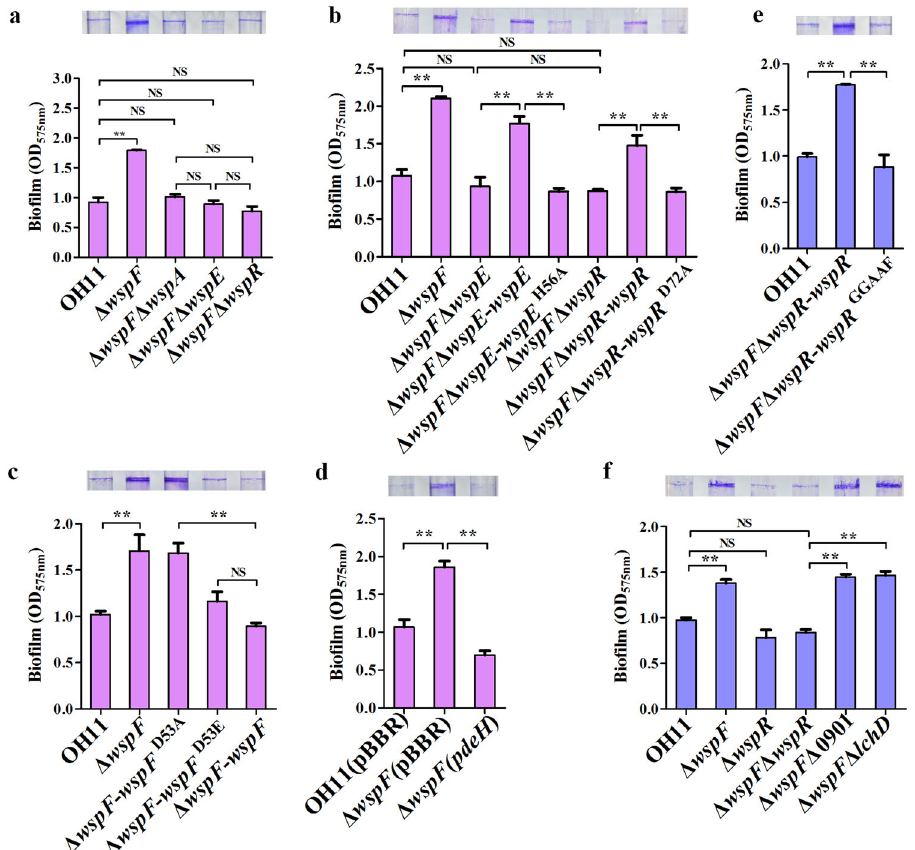
Fig. 2 Wsp signaling system regulates bio fi lm formation in response to c-di-GMP. a Effects of several selected Wsp signaling components on bio fi lm biomass through combinatorial mutations of the respective encoding genes. Δ wspF Δ wspA , Δ wspF Δ wspE or Δ wspF Δ wspR represent double mutations. b Involvement of the key WspE autokinase residue (H56) or WspR phosphor-accepting residue (D72) in bio fi lm formation. Δ wspF Δ wspE - wspE and Δ wspF Δ wspE - wspE H56A represent native wspE or its variant ( wspE H56A ) that were inserted into the chromosome of Δ wspF Δ wspE double mutant; Δ wspF Δ wspR - wspR and Δ wspF Δ wspR - wspR D72A represent the native wspR and its variant ( wspR D72A ) that were individually inserted into the chromosome of Δ wspF Δ wspR . c The involvement of key WspF phosphor-receiving residue on bio fi lm biomass. Δ wspF - wspF D53A and Δ wspF - wspF D53E indicate the wspF variation (substitution of phosphor-receiving residue D53 to A53 or E53, respectively), which was individually inserted into the chromosome of wspF mutant. d The role of c-di-GMP concentration in bio fi lm biomass. Δ wspF ( pdeH ) denotes Δ wspF carrying plasmid-borne pdeH driven by a constitutive promoter of the vector, which produces active c-di-GMP PDE from E. coli. Δ wspF (pBBR) indicates Δ wspF carrying an empty vector. e The role of key GGEEF motif of WspR in bio fi lm biomass. Δ wspF Δ wspR - wspR GGAAF represents a wsp R variant by replacing of GGEEF motif with GGAAF, which was inserted into the chromosome of Δ wspF Δ wspR . f WspR, but not the other two potential DGCs ( Δ 0901 and Δ lchD ), mediates WspF signaling in bio fi lm biomass. Two delta symbols indicate gene double mutants. Statistical comparisons were performed using one-way ANOVA of GraphPad software (GraphPad, La Jolla, CA). In all assays, mean data ± SD from three experiments were shown, **P < 0.01. NS means not signi fi